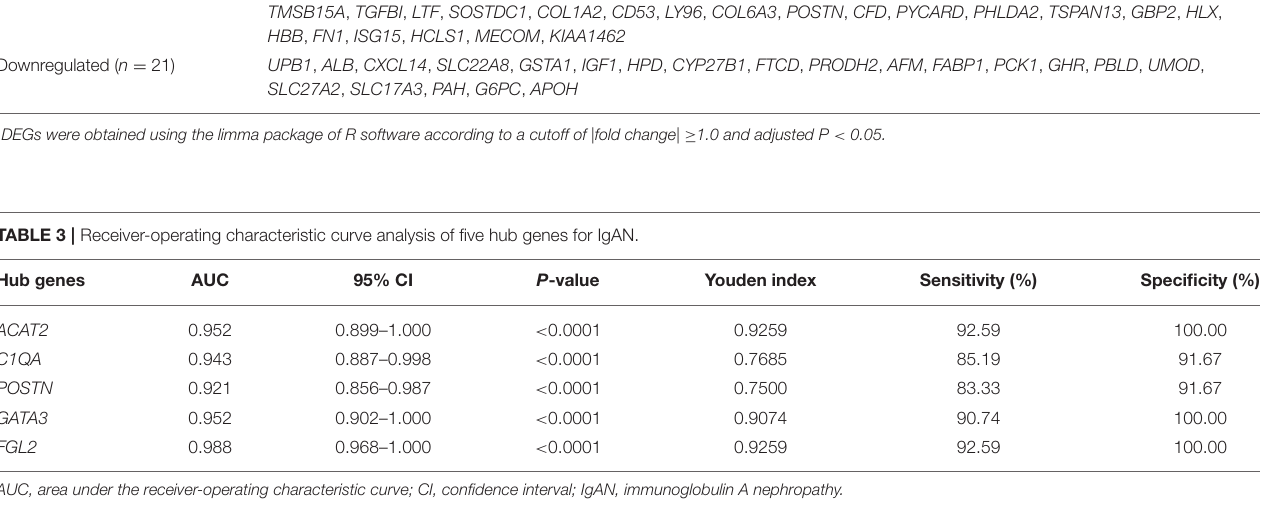
TABLE 2 | Overlapping differentially expressed genes (DEGs) in the GSE93798 and GSE104948 datasets * . Direction of gene expression change